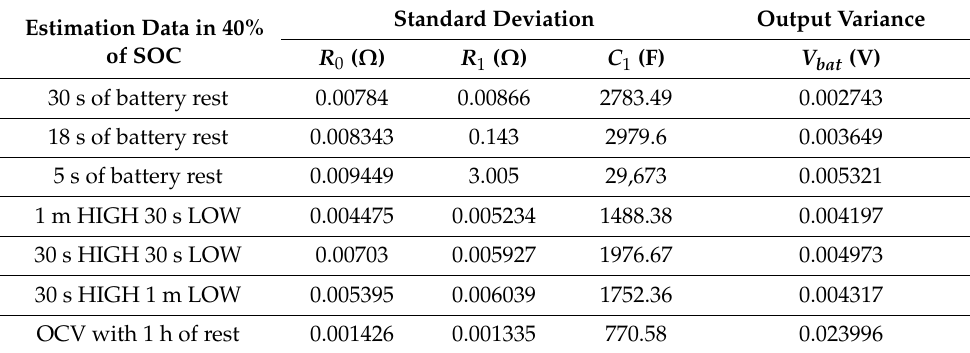
Table 8. Estimated initial states, standard deviation, and output variance of all experiment designs.